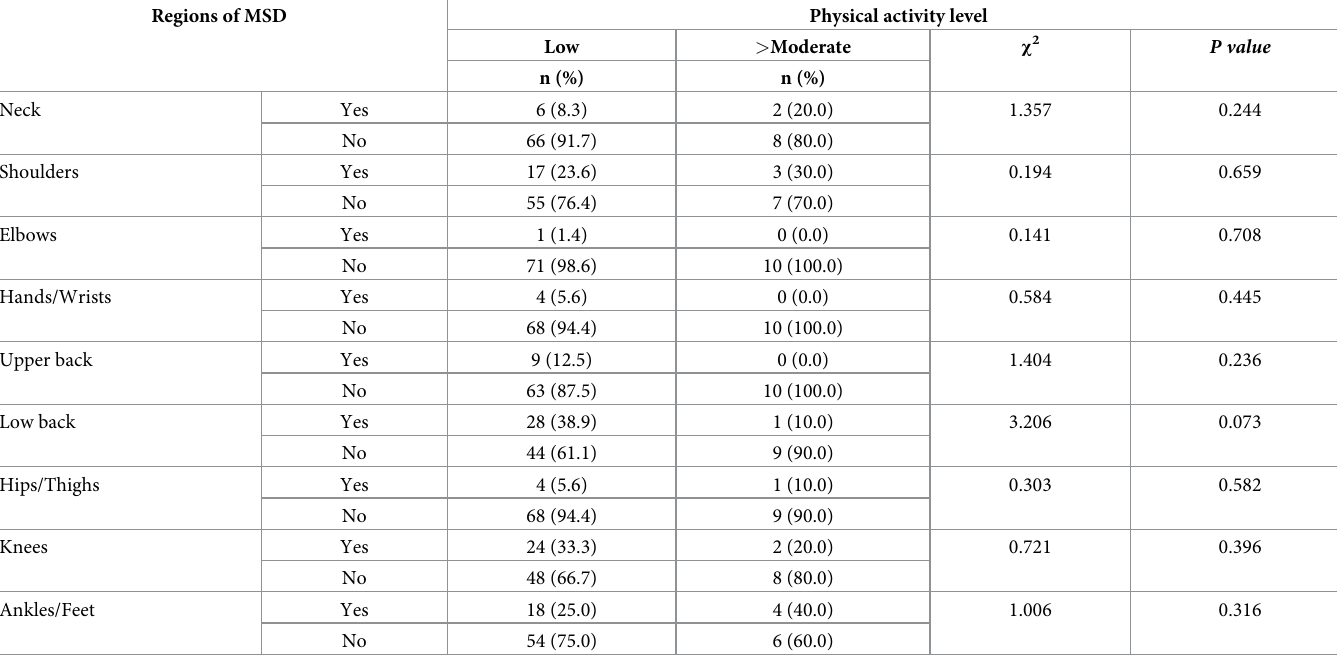
Table 4. The association between MSD between 9 body parts with physical activity level. Regions of MSD